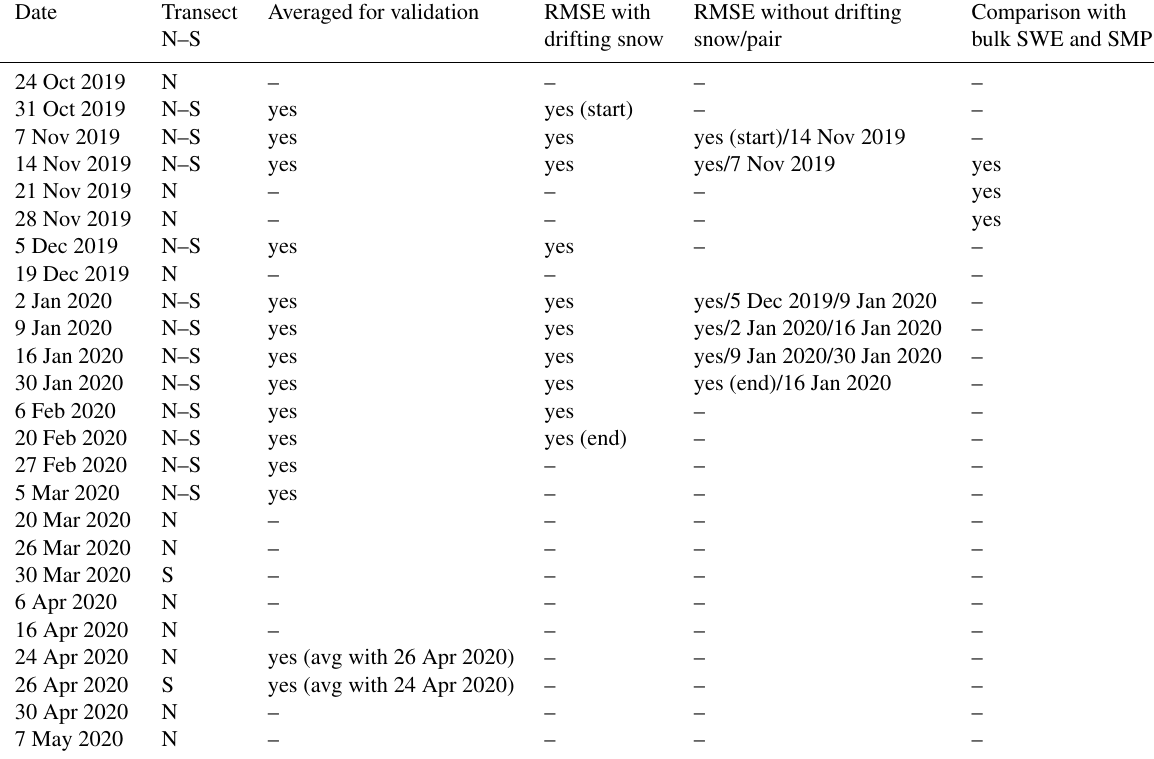
Table 2. Used transect days of sampling and specifications: transect N–S refers to the northern–southern transect; averaged for validation refers to the days when the transect SWE was averaged as shown in Fig. 8; RMSE with drifting snow describes all days when SWE was subtracted from the respective day before, while all days where subtracted in a row; and RMSE without drifting snow/pair refers to the days used for validation when no or low drifting snow mass flux was detected in between while the respective days after which subtraction was performed consecutively are listed as well. The corresponding RMSE values including regression lines are shown in Fig. 12. The comparison with bulk SWE and SMP refers to the dates where direct comparisons are made with SWE along the transect derived from the HS-SWE (Fig.